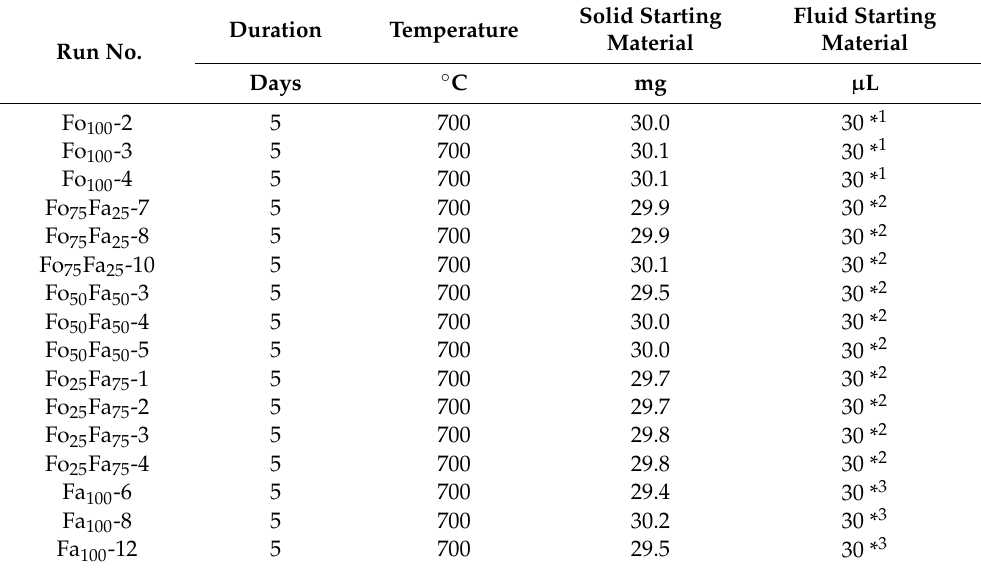
Table 1. Experimental conditions in the olivine solid solution–(Ni 2+ , Mg 2+ , Co 2+ , Zn 2+ , Fe 2+ , Mn 2+ )Cl 2 –H 2 O system.